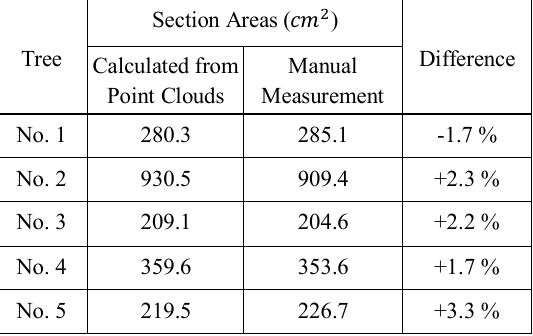
Table 2. Section areas at the breast height